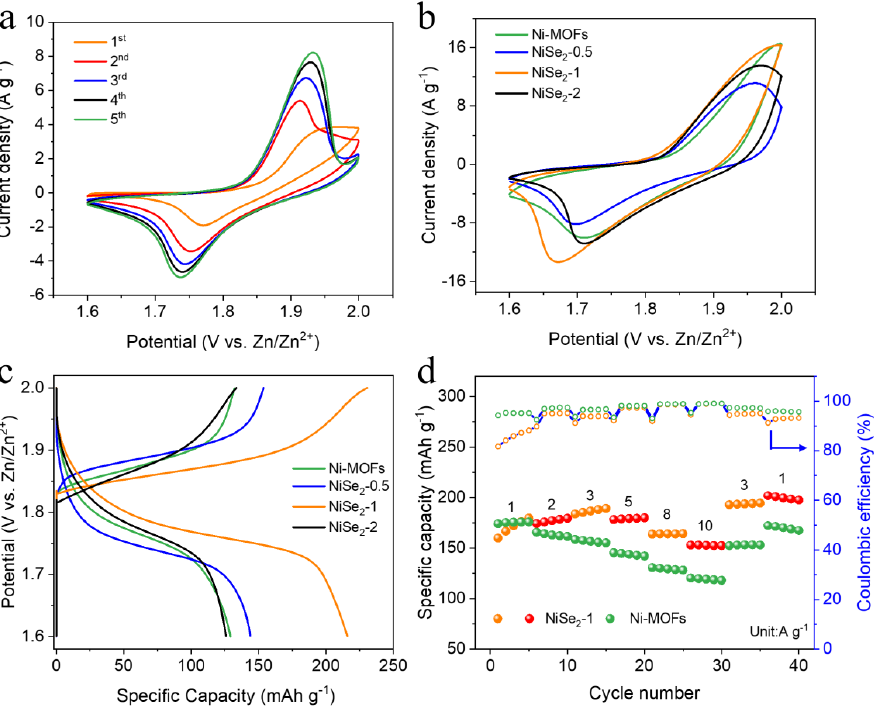
Figure 3. ( a ) CV curves of NiSe 2 -1 at a scan rate of 1 mV s − 1 for initial preactivation. ( b ) CV curves of Ni-MOFs and NiSe 2 − X (X = 0.5, 1, 2) at the same scan rate of 5 mV s − 1 . ( c ) GCD curves of Ni-MOFs and NiSe 2 − X (X = 0.5, 1, 2) at the same current density of 3 A g − 1 . ( d ) Rate performances and CE of Ni-MOFs and NiSe 2 −